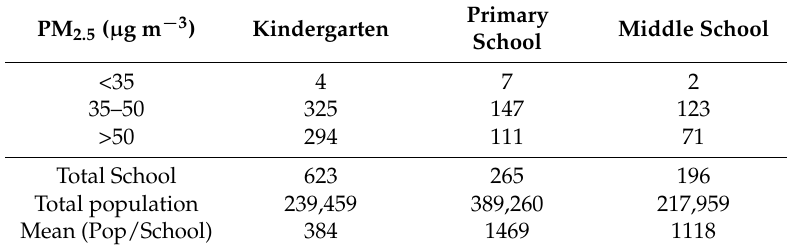
Table 4. The number of Kindergarten, Primary School and the Middle Schools by the three classes of annual PM 2.5 concentration and the population